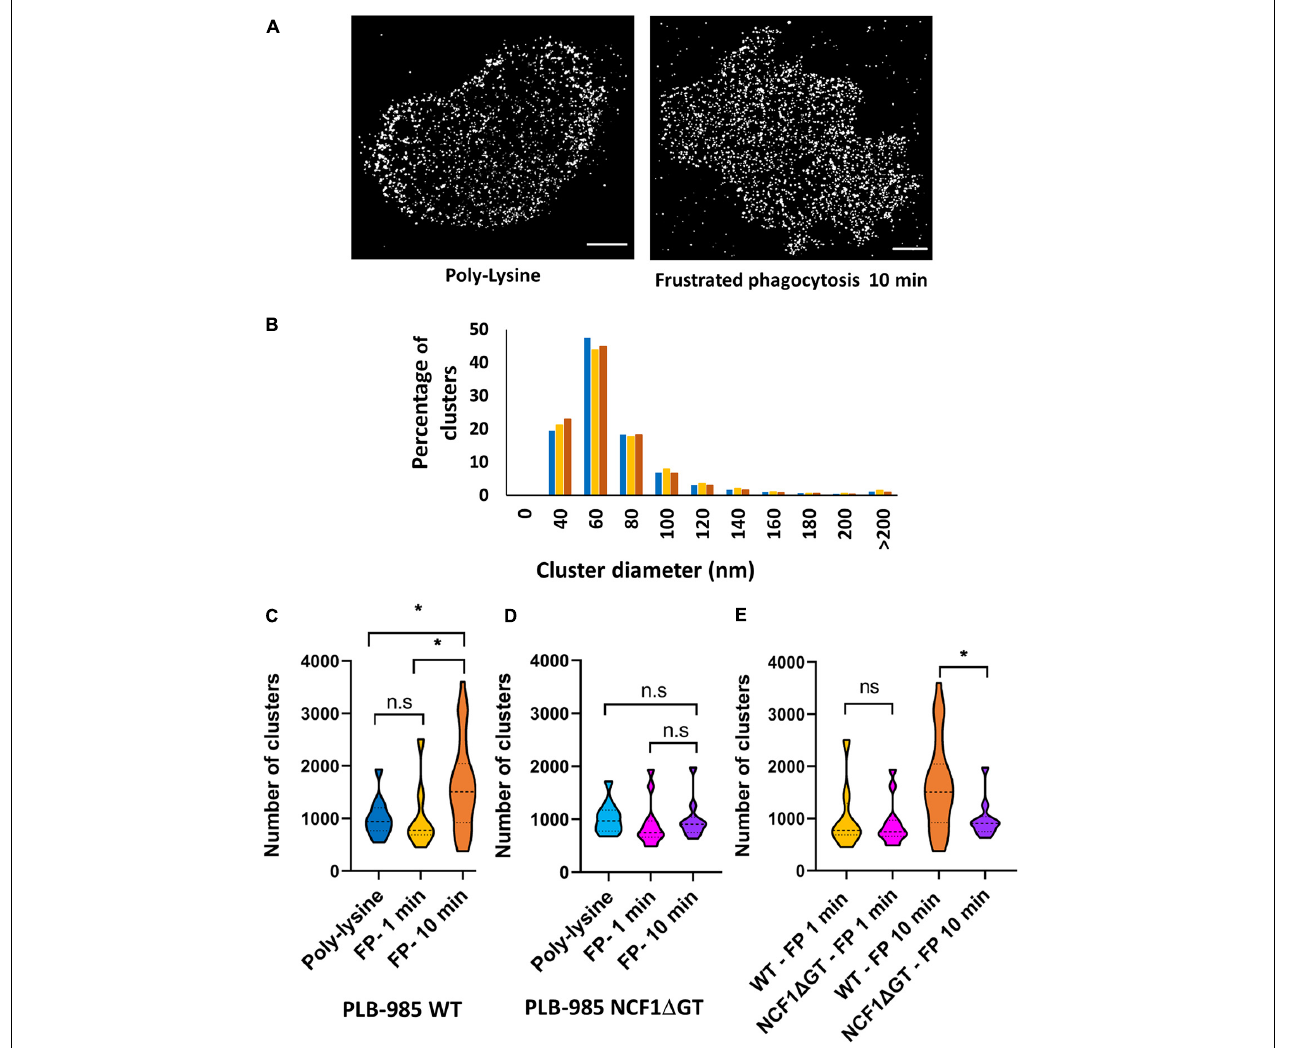
FIGURE 4 | The number of NOX2 nanoclusters increases during frustrated phagocytosis in PLB-985 WT cells but not in PLB-985 NCF1 (cid:49) GT cells. Cells were incubated on poly-lysine or for 1 or 10 min on IgG-coated coverslips. The latter conditions promoted frustrated phagocytosis. Following fixation and permeabilization, NOX2 labeling was observed using dSTORM in a TIRFM configuration. (A) Representative images of NOX2 in PLB-985 WT cells coated on poly-lysine or following 10 min on IgG-coated coverslips. (B) Clusters of NOX2 were detected using SR-Tesseler software. The graph illustrates the distribution of NOX2 nanoclusters according to size on the PLB-985 WT cell surface in the different conditions: non-activated (poly- L -lysine, blue, 11 cells) or after 1 min (yellow, 8 cells) and 10 min (red, 28 cells) of frustrated phagocytosis. Three independent experiments. (C,D) Numbers of NOX2 nanoclusters on the cell surface in the different conditions described above for PLB-985 WT cells (C) and PLB-985 NCF1 (cid:49) GT cells (D) . For D, the conditions are the same as C: non-activated cells (cyan, 10 cells), 1 min (pink, 12 cells) or 10 min (purple, 10 cells) of frustrated phagocytosis, three independent experiments. FP: frustrated phagocytosis. (E) Comparison between the number of clusters in PLB-985 WT and PLB-985 NCF1 (cid:49) GT cells during frustrated phagocytosis for 1 or 10 min. Each violin plot represents the spread of the values. The interquartile range and medians are represented as dotted line. * p < 0.05; ns: non-significant (Mann Whitney tests).